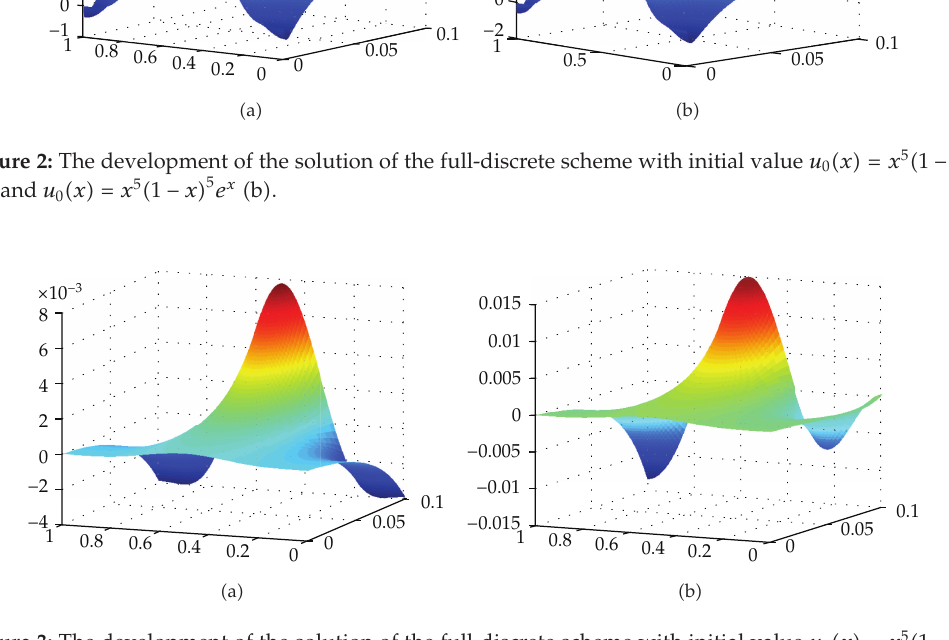
Figure 3: The development of the solution of the full-discrete scheme with initial value u 0 (cid:7) x (cid:8) (cid:9) x 5 (cid:7) 1 − x (cid:8) 5 (cid:7) a (cid:8) and u (cid:7) x (cid:8) (cid:9) x 5 (cid:7) 1 − x (cid:8) 5 e x (cid:7) b (cid:8) . 0